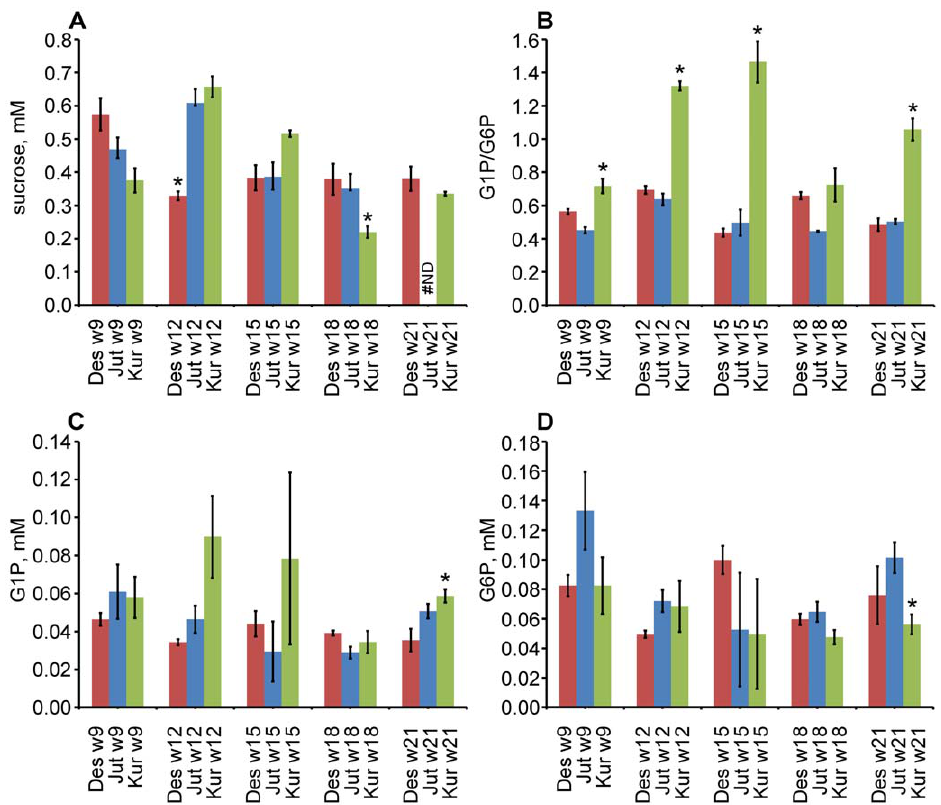
Figure 3. Steady state tuber concentration of sucrose and glucose phosphates. A. Sucrose concentrations A: Example chromatogram indicating G1P and G6P peaks. B: G1P/G6P ratios. C: G1P concentrations. D: G6P concentrations. Error bars indicate standard error of measurement. The asterisk indicates metabolite levels significantly different for Kuras versus Desiree and Jutlandia (p-value , 0.05). The determination of G1P/G6P is much more accurate than individual determination of G1P and G6P (see text for detail).